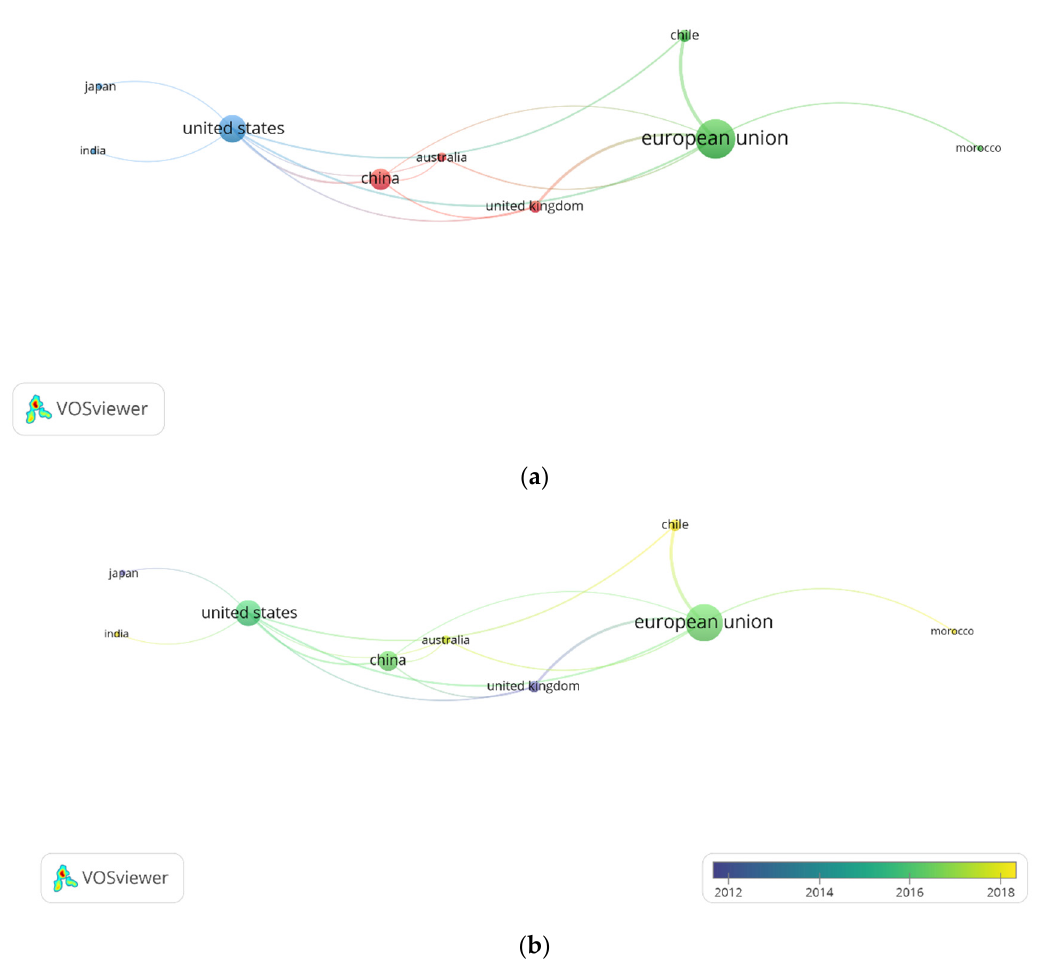
Figure 7. Relationship between countries/territories. ( a ) Relationship between country clusters, and ( b ) Highlights of the date of publication. ( b ) Highlights of the date of